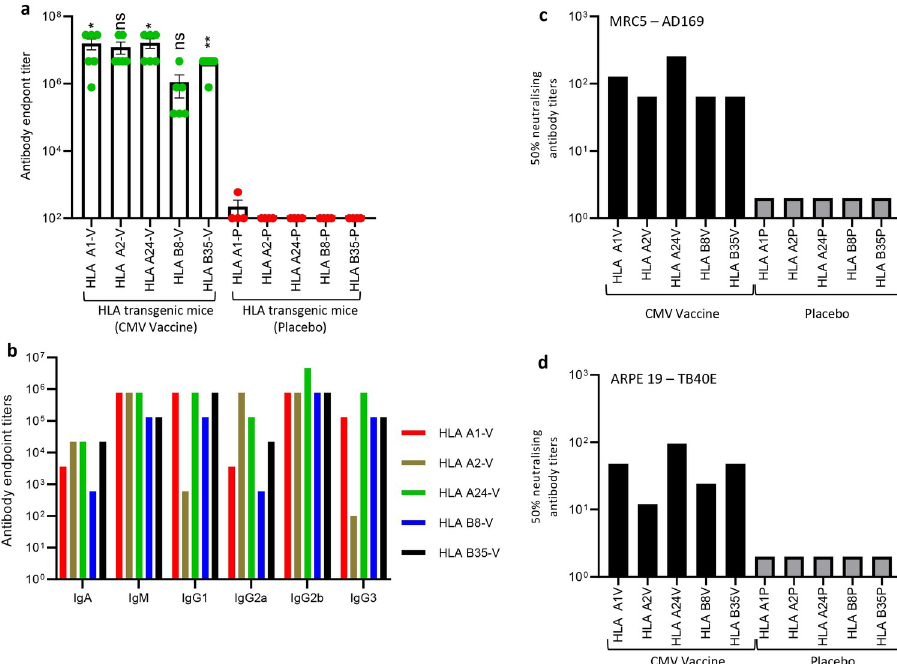
Fig 5. CMV vaccine induces gB-specific humoral immune responses in multiple human HLA expressing mice: HLA expressing mice (HLA A1, HLA 2, HLA A24, HLA B8 and HLA B35) were immunized with CMV vaccine (N = 6) or placebo (N = 4) as outlined in Fig 3A. Peripheral blood was collected on day 28 and assessed for gB-specific humoral immune responses using ELISA and CMV neutralisation assays. (a) CMV gB-specific Ig endpoint titres on day 28 in serum samples of HLA expressing mice immunized with CMV vaccine. (b) Prevalence of CMV gB-specific antibody isotypes (IgM, IgA, IgG1, IgG2a, IgG2b and IgG3) in pooled serum samples on day 28. (c and d) Neutralizing antibody titres in mice immunized with CMV vaccine. To determine the neutralising antibody responses, pooled serum samples from individual groups were serially diluted, and pre-incubated with CMV AD169 or TB40/E strains. MRC-5 or ARPE 19 cells were infected with serum-treated virus and virus infectivity was determined using an IE-1/IE- 2 micro-neutralization assay. Error bars represent the mean ± SEM. Statistics are indicated in comparison with control group. If statistics are not indicated, then the comparison was not significant (ns). P vales were also calculated between the vaccinated mice. In Fig 5A HLA A24 vs HLA A1 p = 0.93, HLA A24 vs HLA A2 p = 0.59, HLA A24 vs HLA B8 p = 0.03 and HLA A24 vs HLA B35 p = 0.06. � P < 0.05; �� P < 0.01 by Welch’s t